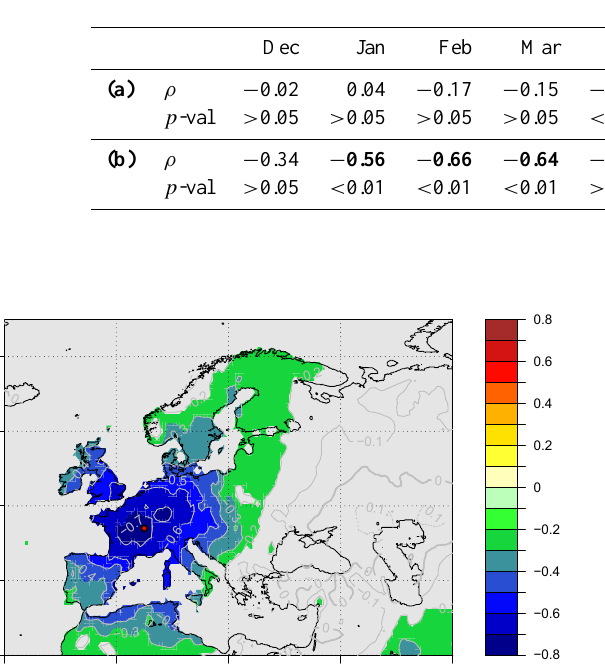
Table 1. GHD correlated with averaged monthly near-surface temperatures of France (5.5 ◦ W to 6 ◦ E and 42 ◦ N to 51.5 ◦ N) from CRU (1901–2002) (Mitchell et al., 2003). (a) Unfiltered data (b) Low-pass filtered data (1/10 year cutoff). Significant correlation values ( p < 0.05) are bold.